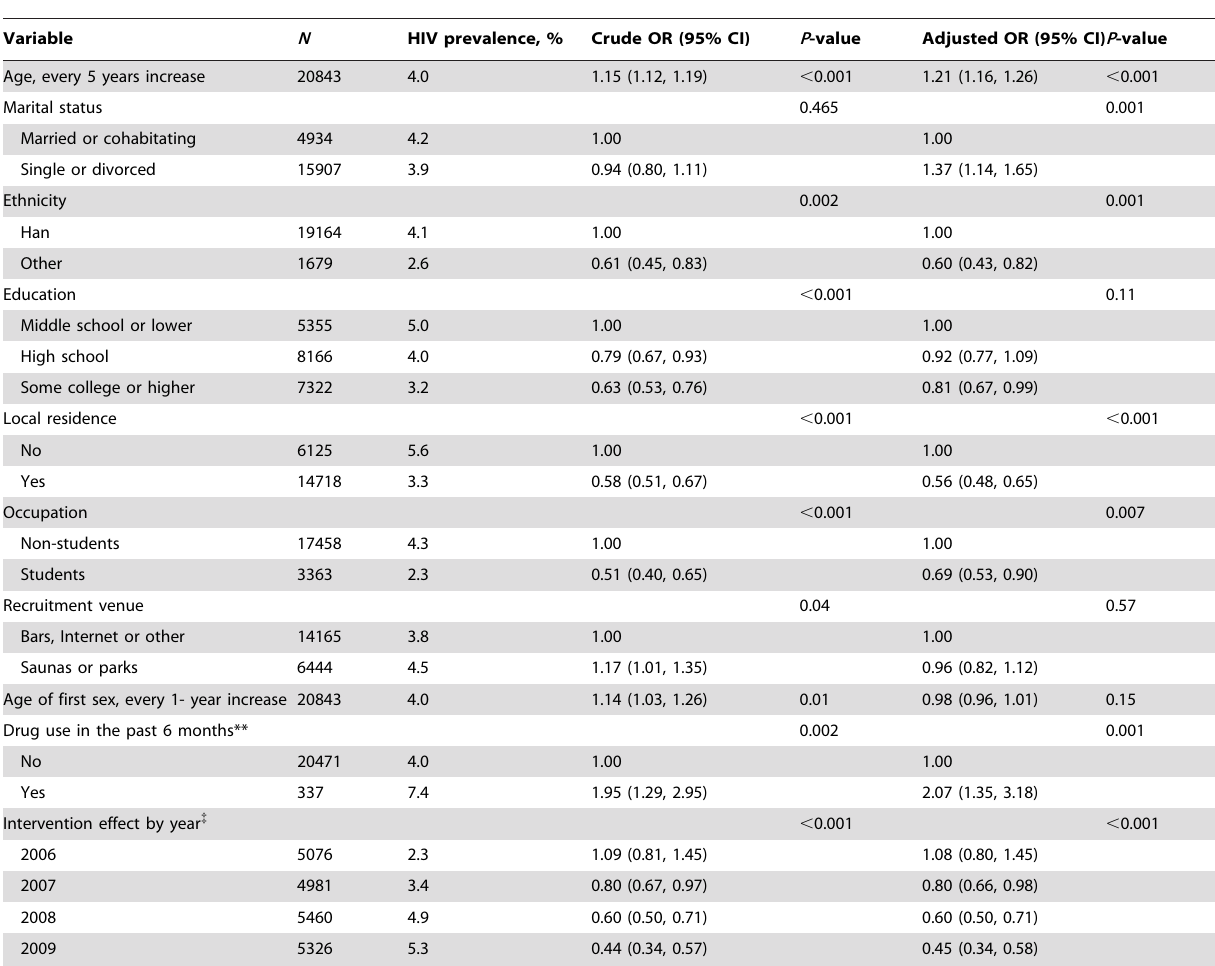
Table 7. Logistic regression of HIV prevalence among MSM in 16 Chinese cities (surveys from all 4 years, 2006–2009).